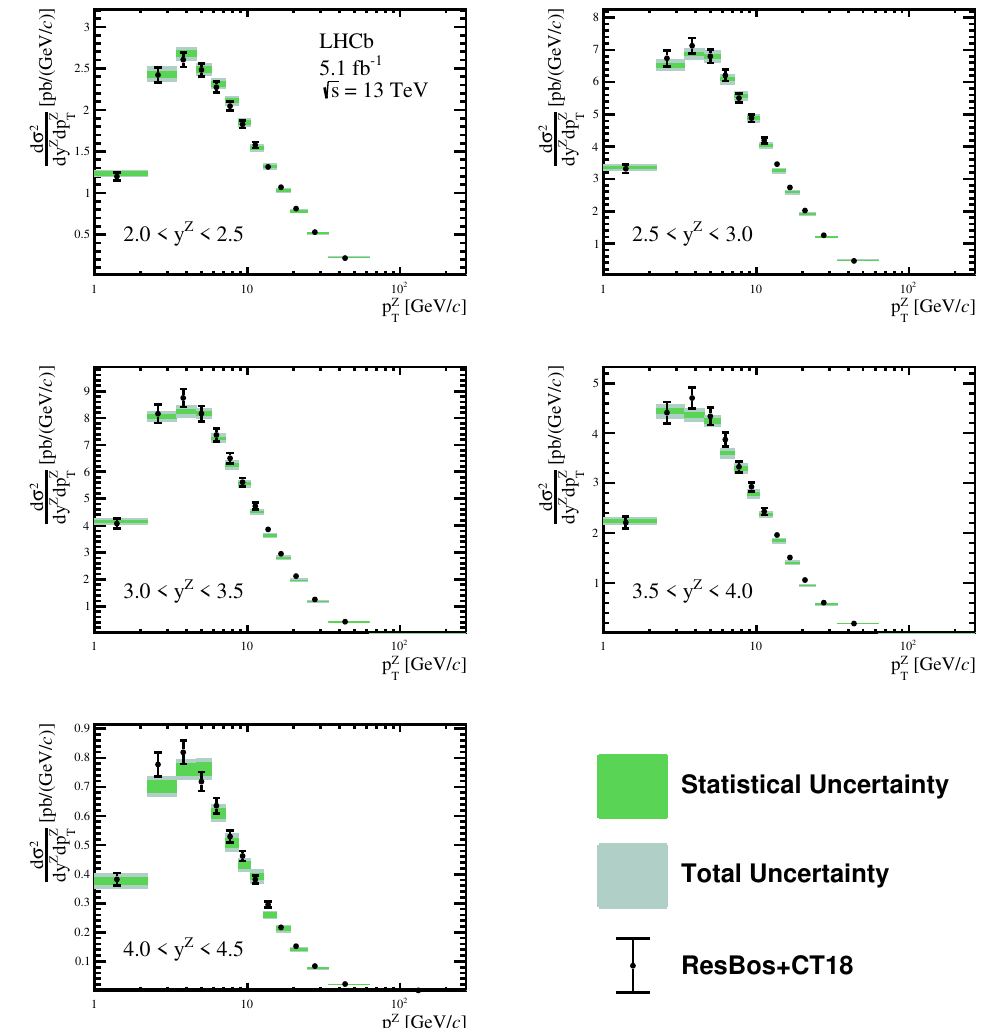
Figure 6 . Measured double differential cross-section as a function of p Z with ResBos predictions, with the horizontal bars showing the uncertainty from the